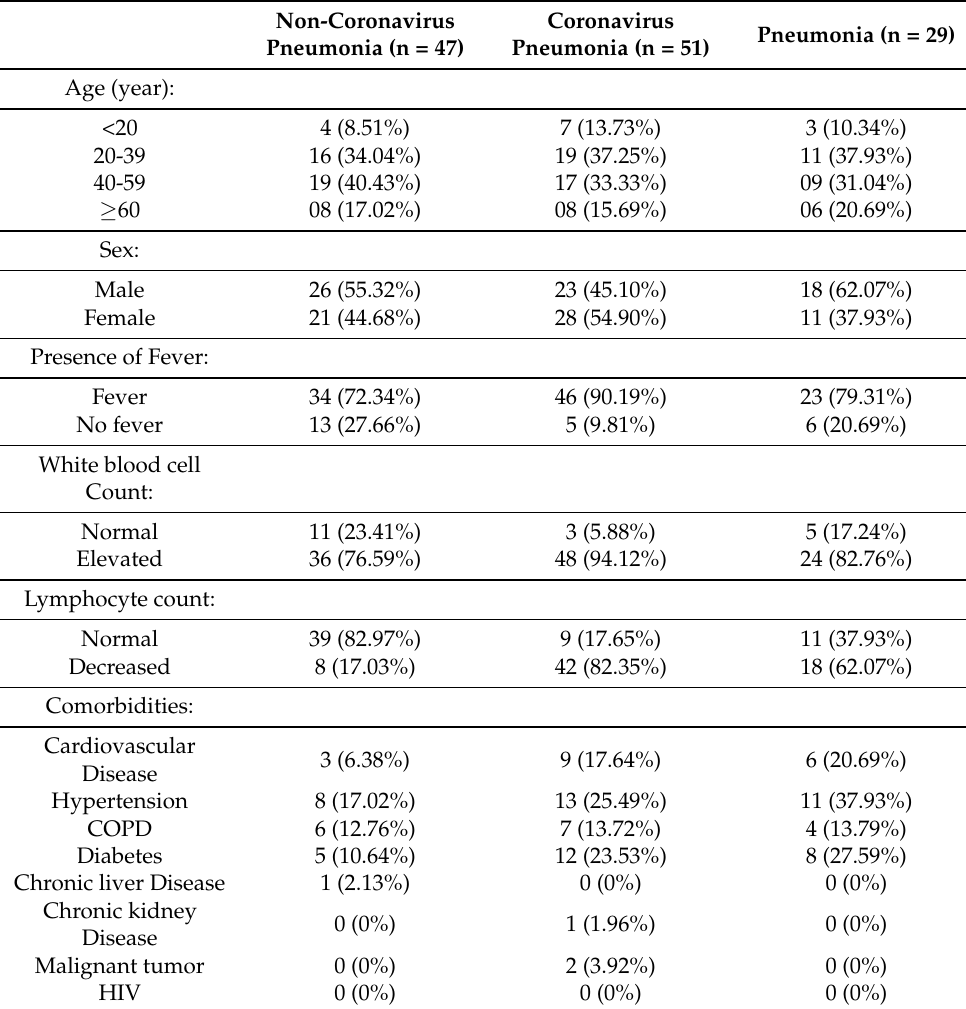
Table 3. Details of the clinical characteristics of